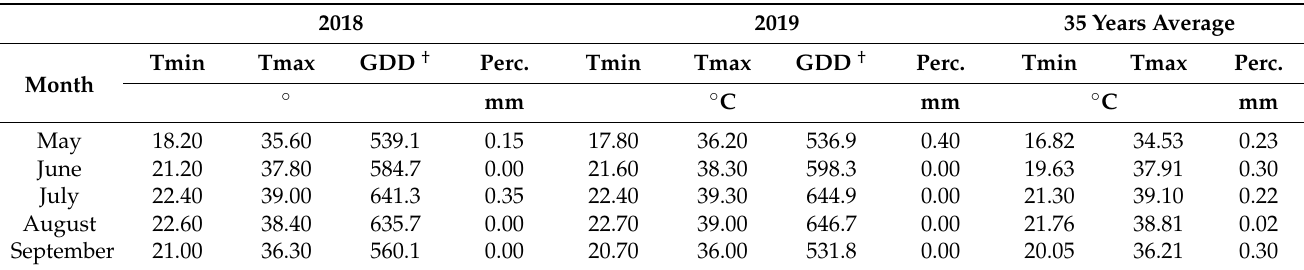
Table 1. Monthly average minimum (Tmin) and maximum (Tmax) temperatures, growing degree days (GDD), and total precipitation (Perc.) in the 2018 and 2019 growing seasons of maize and 35 years of monthly averages (1985 to